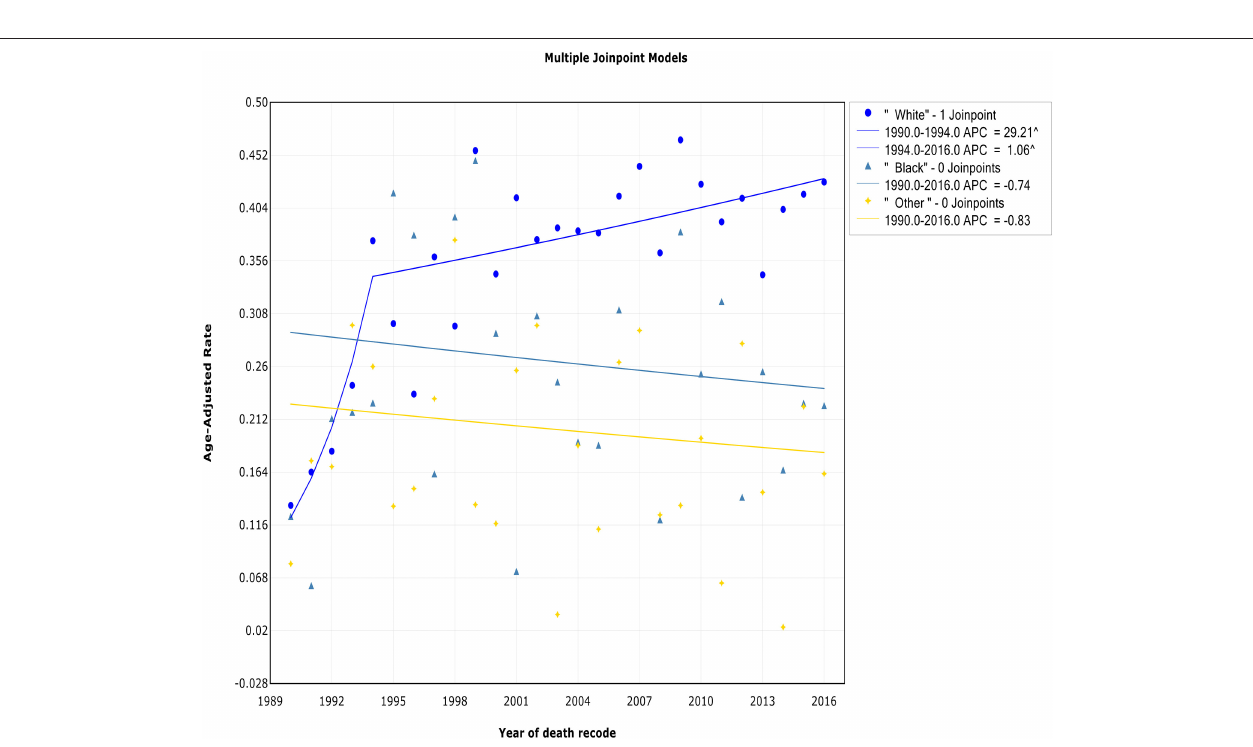
FIGURE 8 | Trends in the annual incidence-based mortality of Waldenström macroglobulinemia in patients stratified according to race.